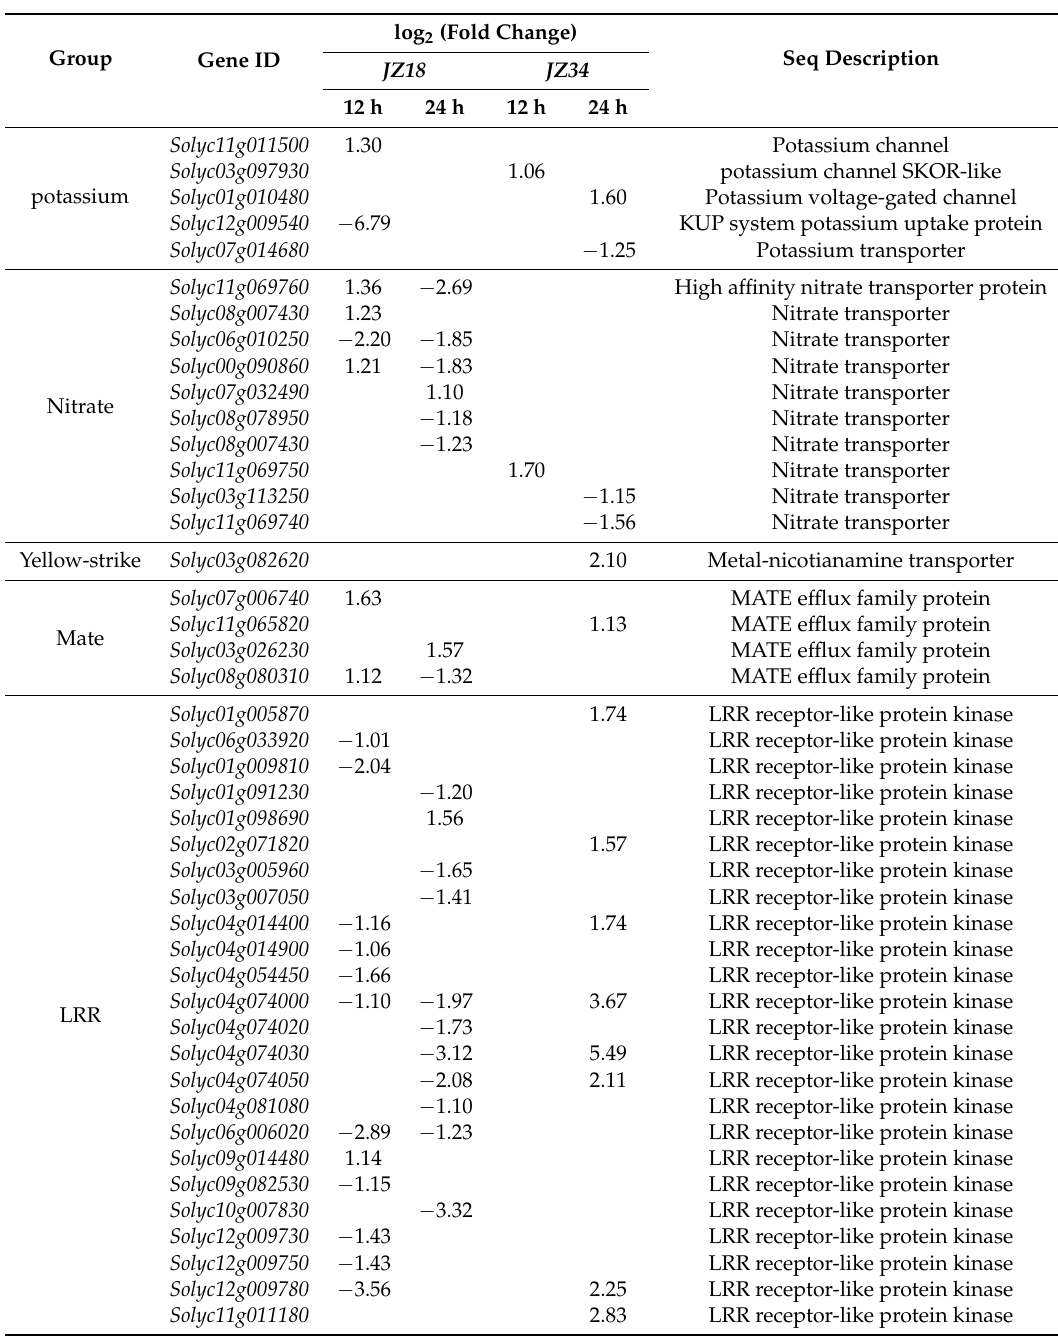
Table 4. Genes encoding protein transporters and kinases showed genotypic differences in response to K + -deficiency (0.5 mM)